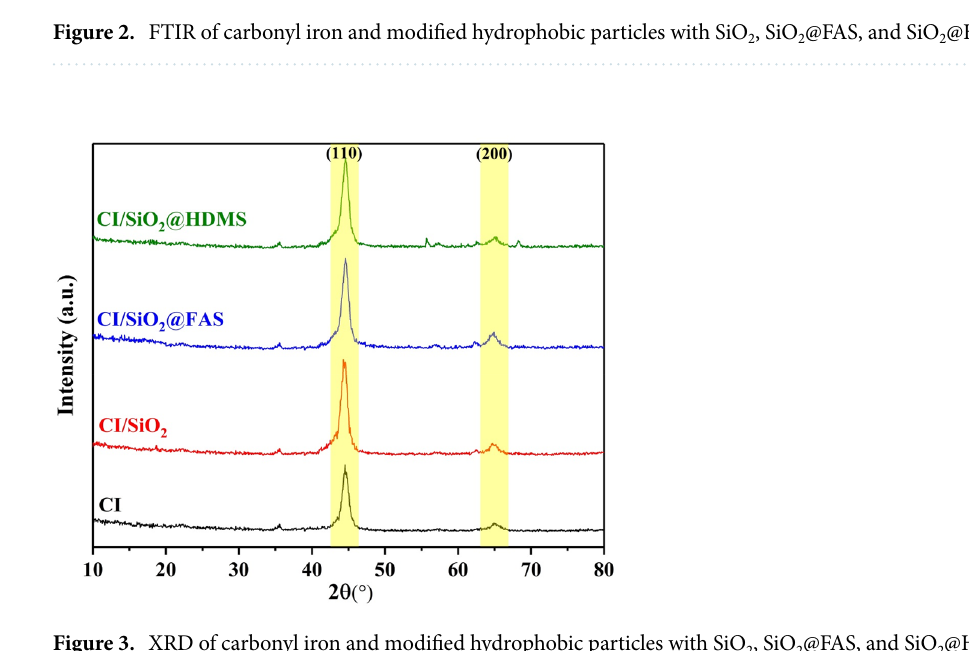
Figure 3. XRD of carbonyl iron and modified hydrophobic particles with SiO 2 , SiO 2 @FAS, and SiO 2